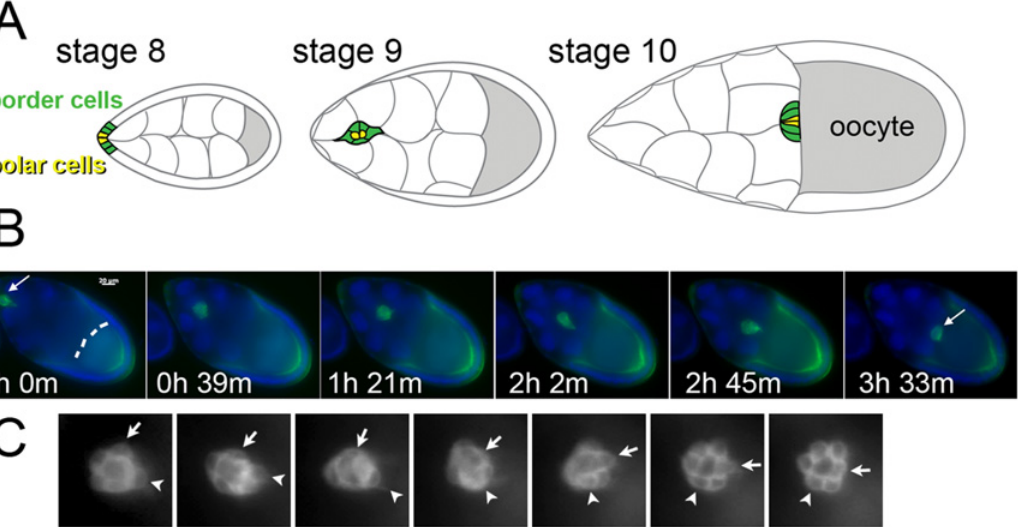
Fig 1. Border cell migration in Drosophila melanogaster egg development. (a) At the beginning of stage eight, the polar cells (yellow) and border cells (green) lie in the follicular epithelium of the developing egg chamber. In stage nine, these cells coalesce to form a cluster that detaches from the epithelium. The cluster then translocates between large nurse cells through the egg chamber to reach the developing oocyte (gray) by stage ten. The border cell cluster migrates about 150 μ m over approximately 4 – 6 hours. (b) Still images from a time-lapse movie of wild-type border cell migration. The motile cells are marked in green by expression of Slbo-life-Act-GFP. The oocyte, which autofluoresces, is indicated by the dashed line. The nuclei of all cells, including the large, polyploid nurse cells, are seen in blue. In the image at time 0, border cells have already clustered (arrow) and begun moving towards the oocyte. In this example, the border cells reached the oocyte border by 3.5h (arrow on right-most panel). (c) Still images at a higher magnification from a time-lapse movie of a different egg chamber. Images differ by 30 minute intervals. The border cells are marked by a membrane-tethered GFP, and show wild-type behavior. Cells can be observed to change relative positions with respect to the front of the cluster as they move toward the right (arrow and arrowhead indicate the same cell over time). See also Supplemental S1 and S2 Movies.